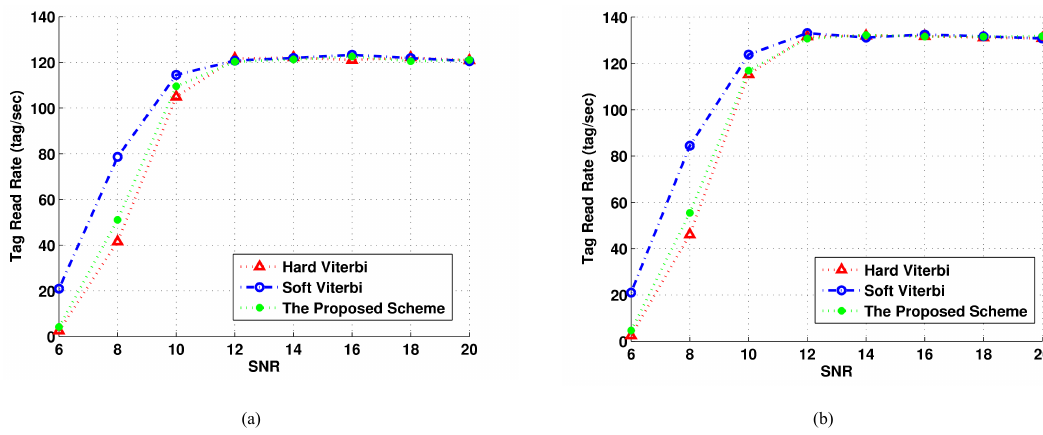
Figure 5. Tag Read Rate versus signal-to-noise ratio (SNR, dB) with different values of the ratio T on / T s : ( a ) T on / T s = 5 and ( b ) T on / T s =